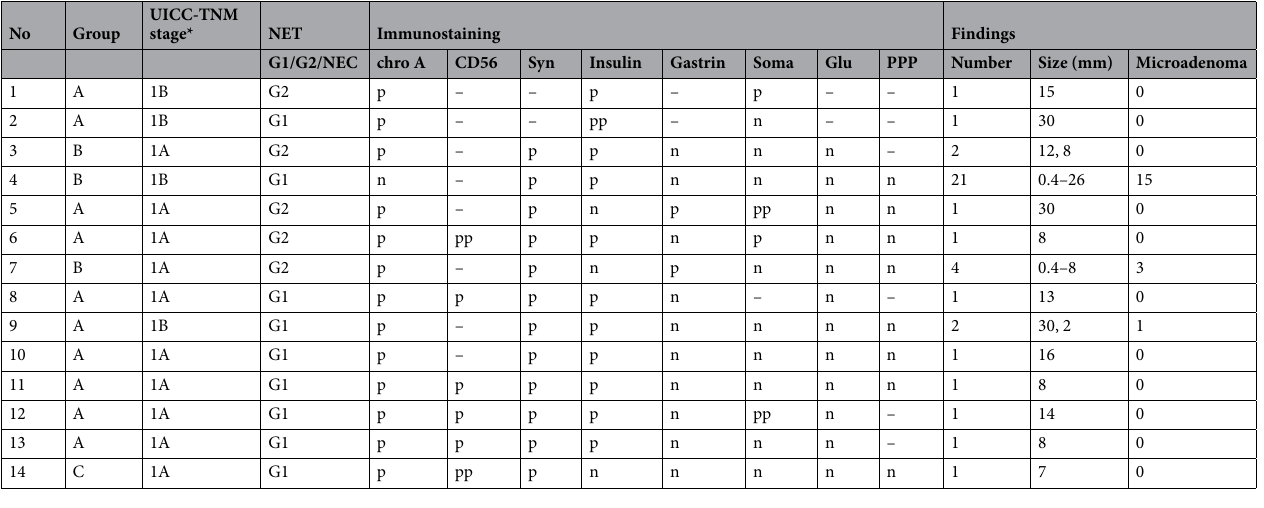
Table 3. Pathological findings (N = 14). chro A chromogranin A, Glu glucagon, n negative, PPP pancreatic polypeptide, pp partial positive, p positive, Syn synaptophysin, Soma somatostatin, UICC-TNM Union